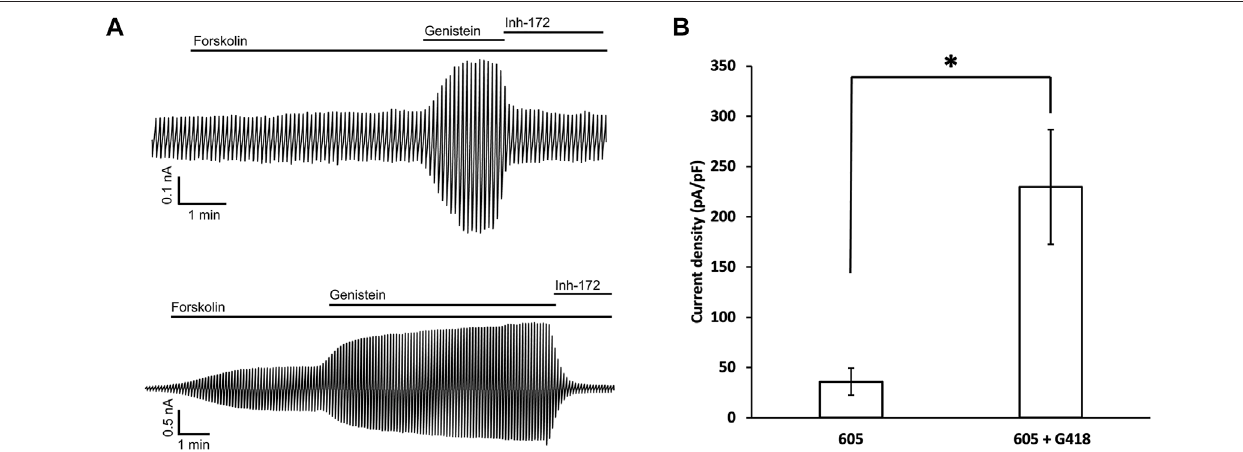
FIGURE 7 | Whole-cell recordings of G542X-CFTR. (A) Whole-cell recordings of G542X-CFTR with incubation in 0.5 μ M C1-605 (upper) and the combination of 0.5 μ M C1-605 plus 100 μ M G418 (lower). The currents were activated by 10 μ M forskolin, potentiated by 30 μ M genistein, and inhibited by 10 μ M CFTRinh-172 (Inh- 172).Themembranepotentialwasheldat0 mVanda200-msvoltagepulseover±100 mVwasappliedevery6 s. (B) Quanti fi cationofthecurrentdensities(at100 mV) inforskolinplusgenisteininthecellsincubatedwithC1-605(N=7)andC1-605+G418(N=16).Thedataarerepresentedasmean±SEM.* p < 0.05byStudent ’ s t